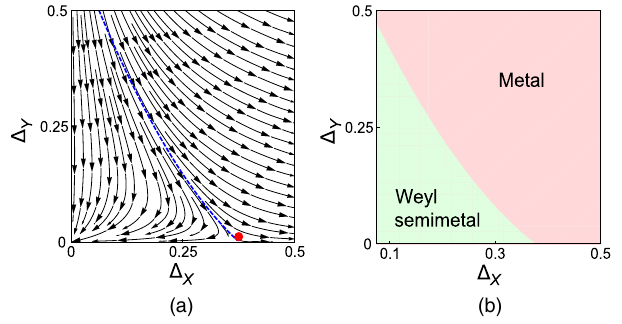
− Δ plane, where A Y 1 . There is only expansion for ϵ d d ¼ ϵ 0 (red dot). The = 2 , Δ A ¼ d Y ¼